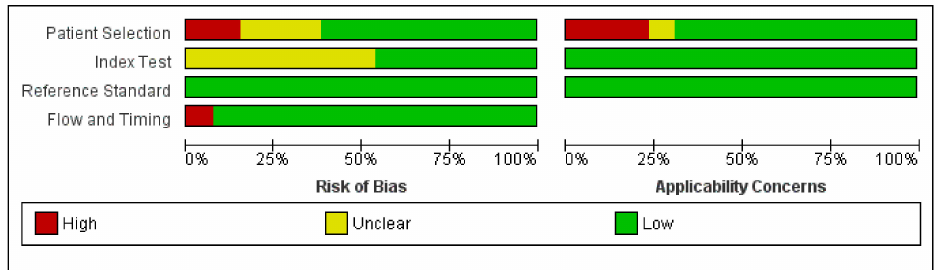
Figure 4. Summarized results of quality assessment.